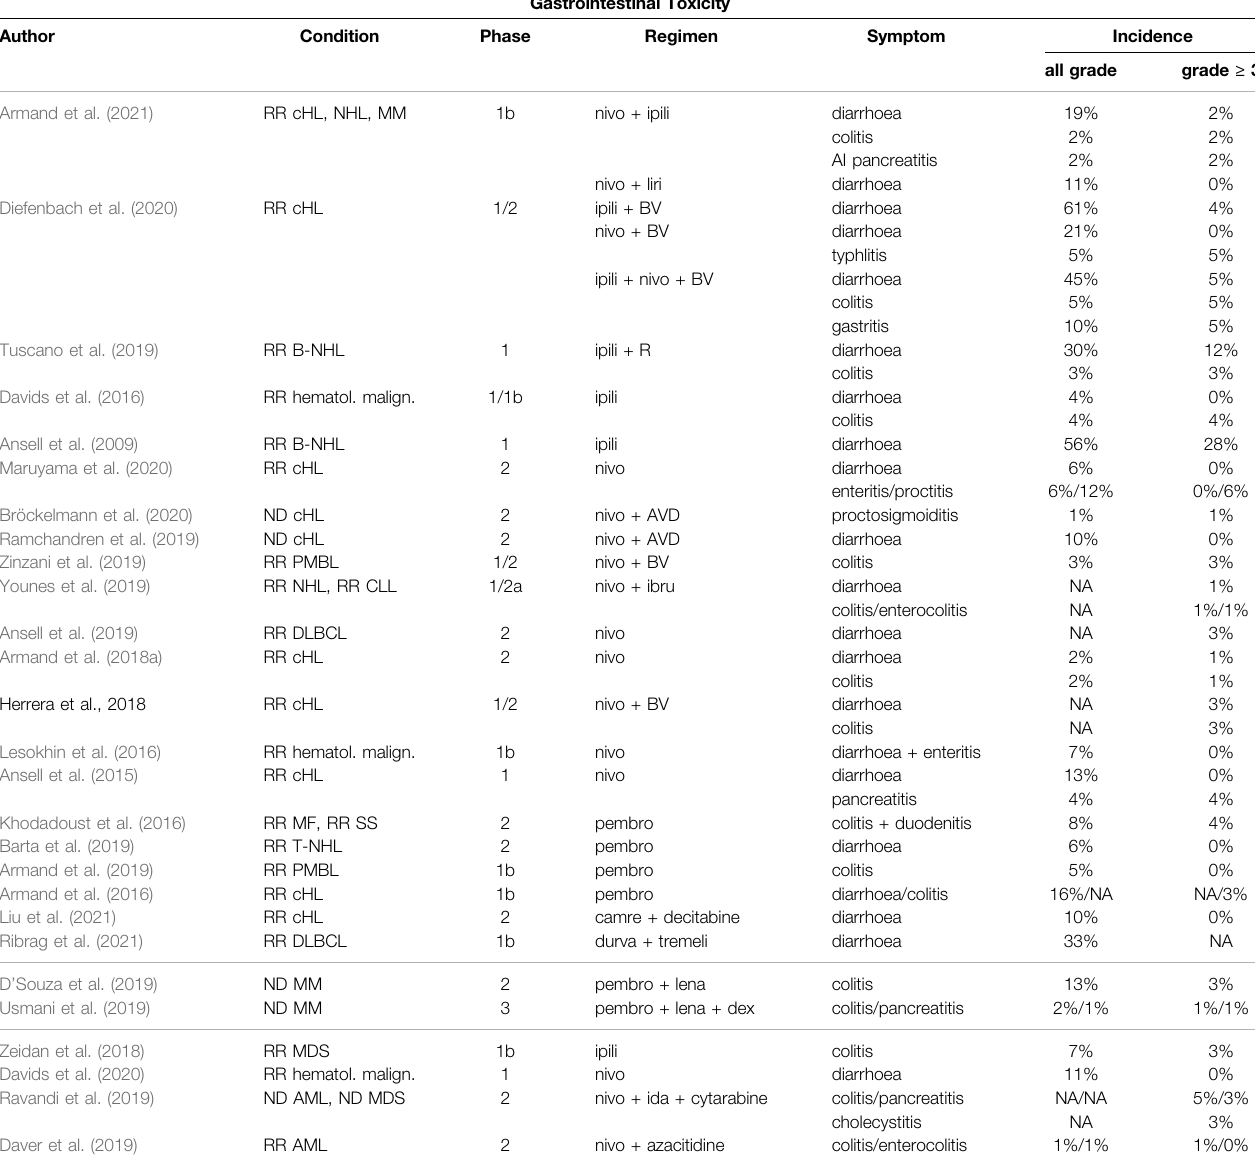
TABLE 4 | Incidence of gastrointestinal irAEs in hematological